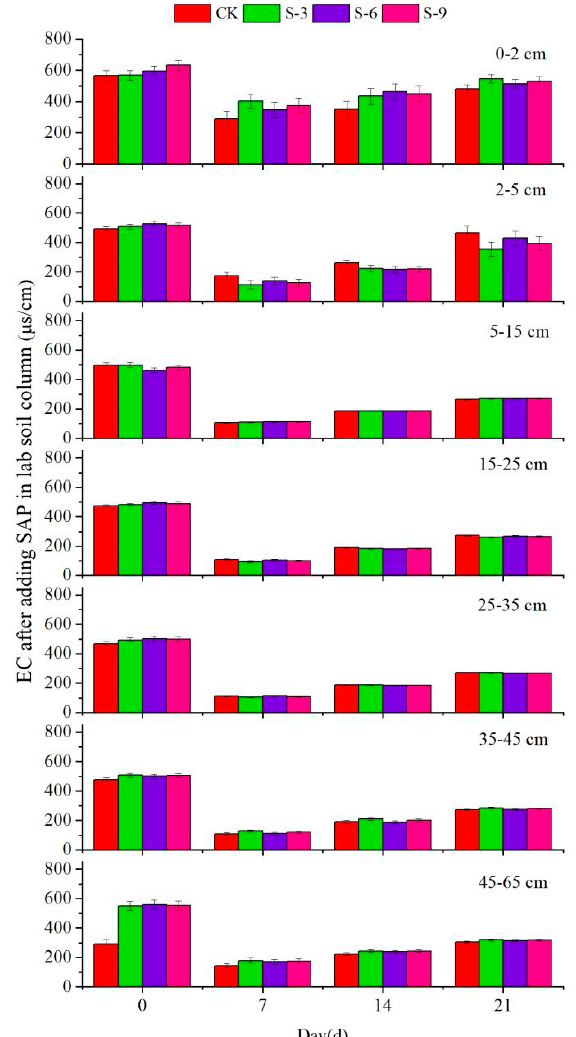
Figure 2. Effect of super absorbent polymer on soil electrical conductivity (EC) parameters with different soil depths in lab soil column (0–65 cm) simulation experiment. CK is control. S-3, S-6, and S-9 represents the application rate of super absorbent polymer at 4.5, 9.0, and 13.5 g/m 2 , respectively. Data are presented in the average with standard error bars ( n = 3).